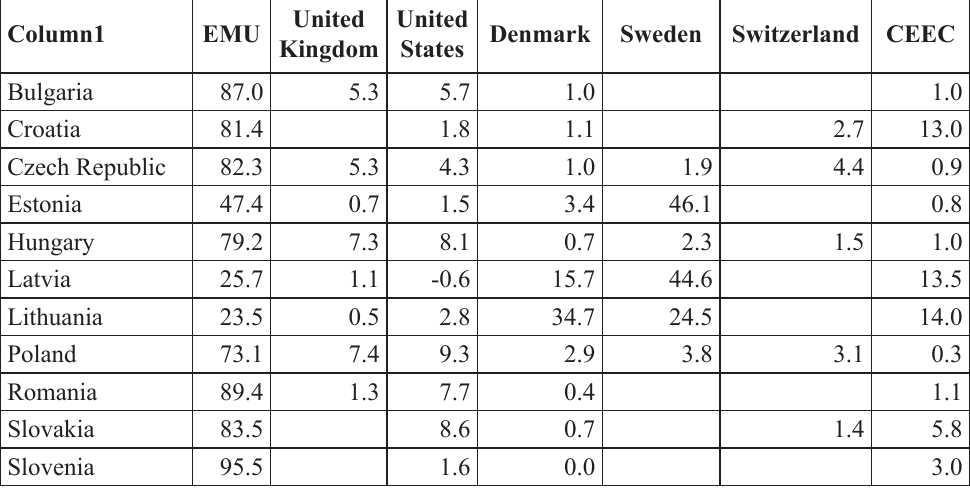
Table 1.1: Central and Eastern European Countries: Foreign Direct Investment Sources Column1